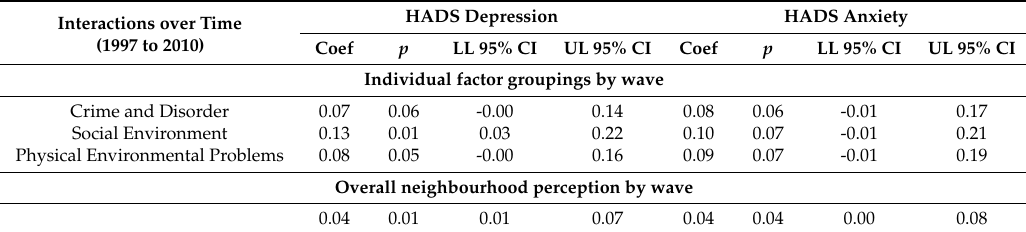
Table 3. Linear change in HADS anxiety and depression scores, neighbourhood perceptions overall and by individual factor groups, over time (1997 to 2010, model 6).